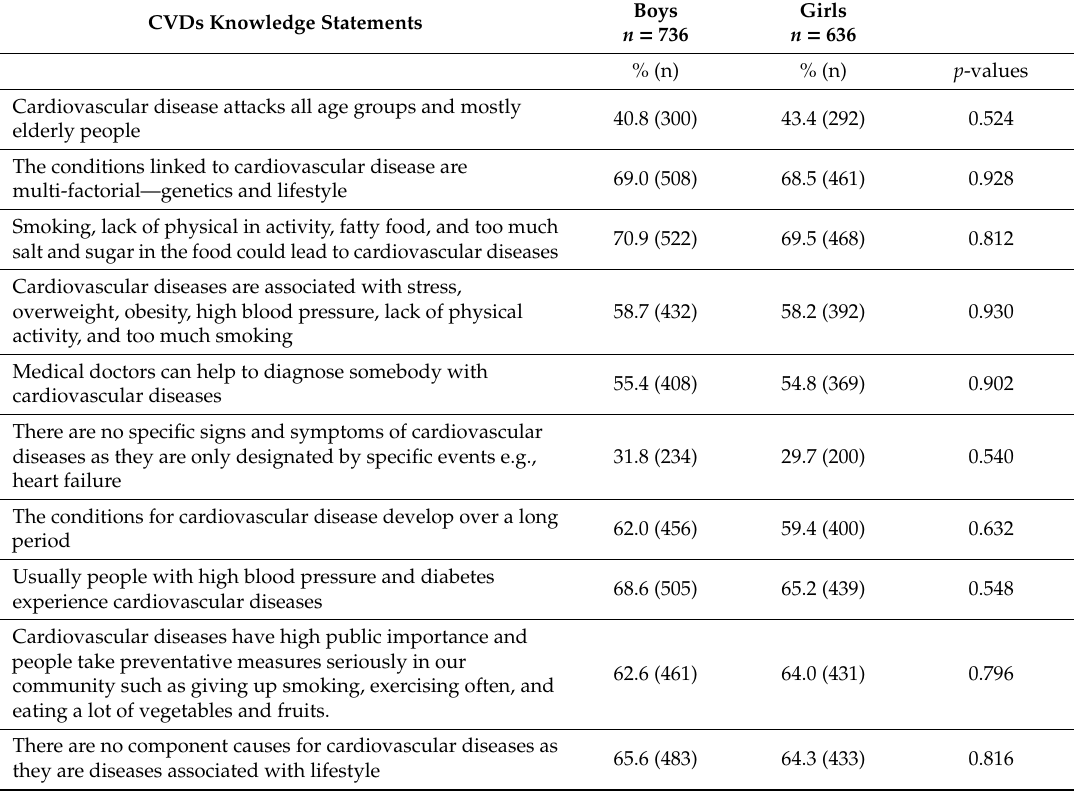
Table 4. Percentage frequencies, frequencies, and p -values for positive response on knowledge of cardiovascular diseases (CVDs) among Ellisras rural children aged 14–22 years.